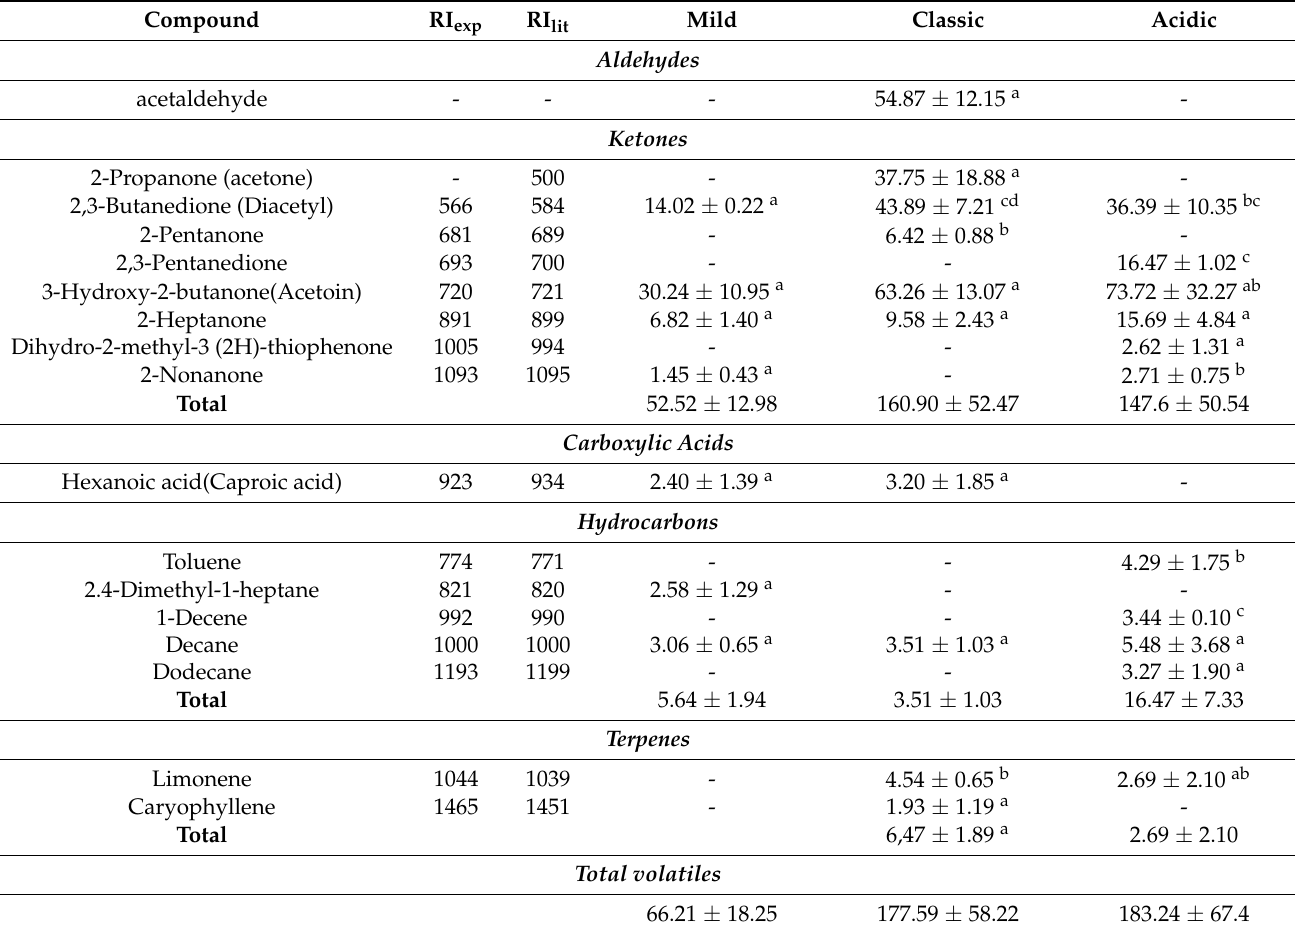
Table 1. Volatile compounds of cow dessert yogurts (mg kg − 1 ), prepared with different cultures without the addition of Bifidobacterium animalis ssp. lactis